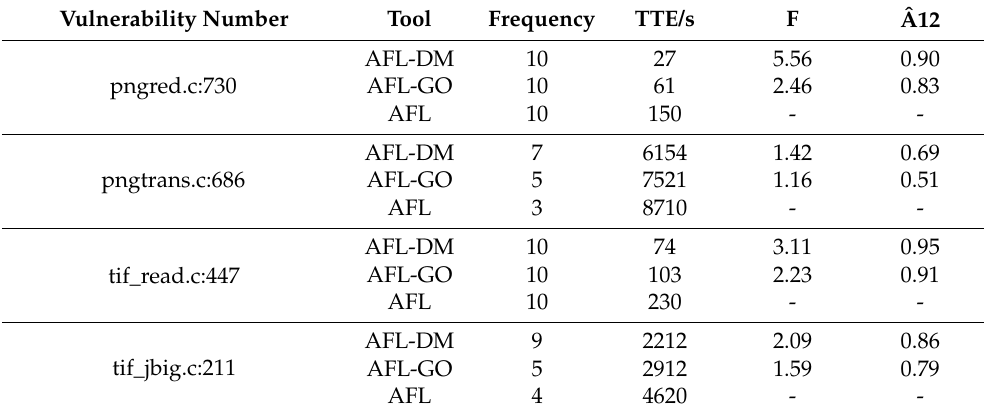
Table 3. Target site coverage